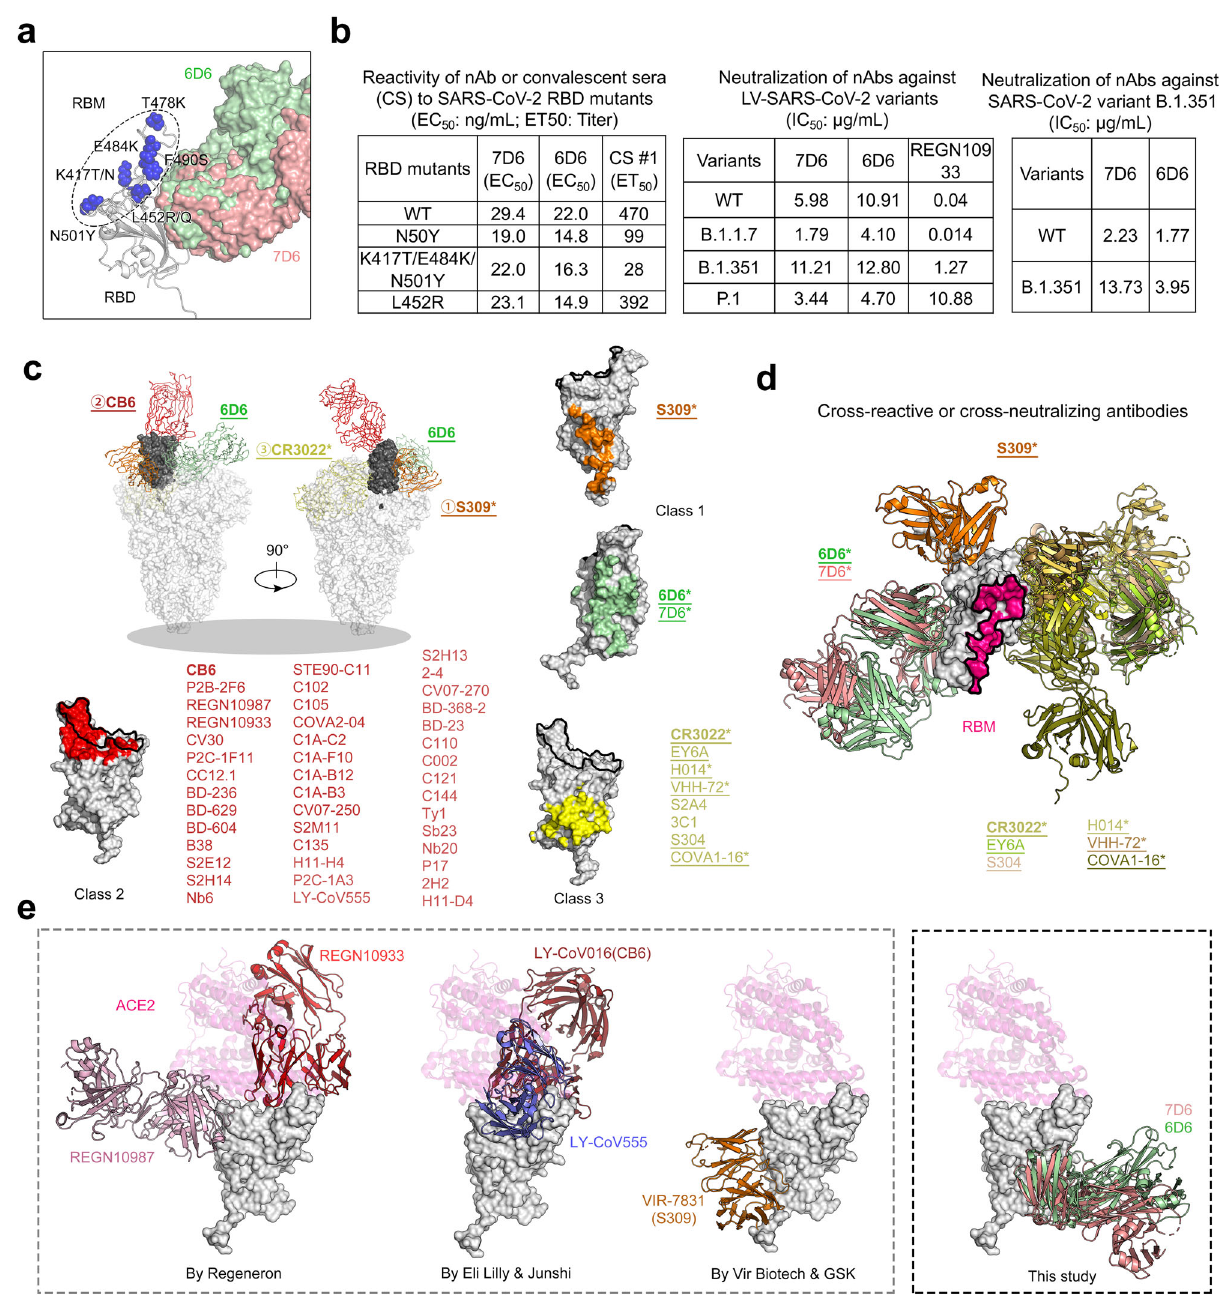
Fig. 4 Mutation resistance of 7D6 and 6D6 and comparison of the 7D6/6D6 site with other binding modes of known RBD nAbs. a Predominant mutations on the RBD in the SARS-CoV-2 variants. None of these mutations occur within the 7D6/6D6 site. b Binding reactivities of 7D6, 6D6 against the RBD mutants and their neutralizing activities against pseudotyped LVs and authentic virus of the major SARS-CoV-2 variant(s). Three convalescent sera and nAb REGE10933 served as control. c Superimposed structures of S trimers (shown as gray surface) and three classes of nAb-RBD complexes, the bound RBD were highlighted in dark gray. The epitopes of the six representative nAbs were shown on RBD separately. nAbs belonging to the same class (with similar epitopes or binding modes) are listed in the corresponding color. The underlined antibodies indicate cross-reactive antibodies and the asterisks indicate cross-neutralizing antibodies. d Superimposed structures of the Class 3 cross-reactive nAbs (CR3022, Ey6A, S304, H014, VHH-72, and COVA1-16), Class 1 cross-reactive nAb (S309, 7D6, and 6D6), showing three different binding orientations. Both two classes of nAbs bind epitopes without overlapping the RBM. e Comparison of 7D6, 6D6 and antibodies clinically used under EUA. REGN10933 + REGN10987 developed by Regeneron Pharmaceuticals Inc., LY-CoV16 (CB6) + LY-CoV555 from Eli Lilly & Company and Junshi Biosciences Inc., VIR-7831(S309) from Vir Biotechnology and GlaxoSmithKline group of companies (GSK). Source data are provided as a Source Data fi movement, as found for the hemagglutinin of the in fl uenza af fi nities (Fig. 2e), suggesting that the RBD might have a range of virus 57,58 . Despite the similar binding orientations and footprints orientations with respect to the NTD, allowing the antibody to bind upon transient exposure of the 7D6/6D6 site. That is, the of the two antibodies, 7D6 has higher af fi nity for the RBD than cryptic 7D6/6D6 site may be exposed transiently by inter-domain for S2P, while the corresponding af fi nities for 6D6 are